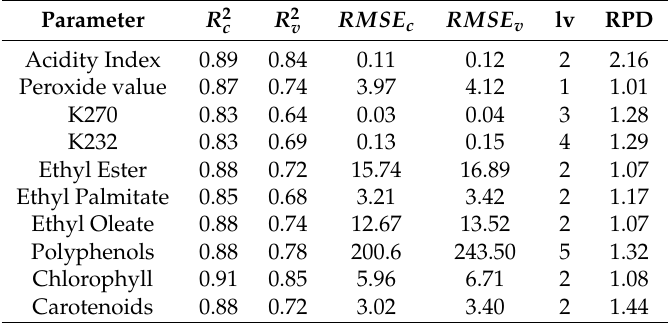
Table 3. Regression coefficient (calibration and validation), root mean square error (calibration and validation), number of PLS components employed in the models for each chemical parameter and ratio of performance to